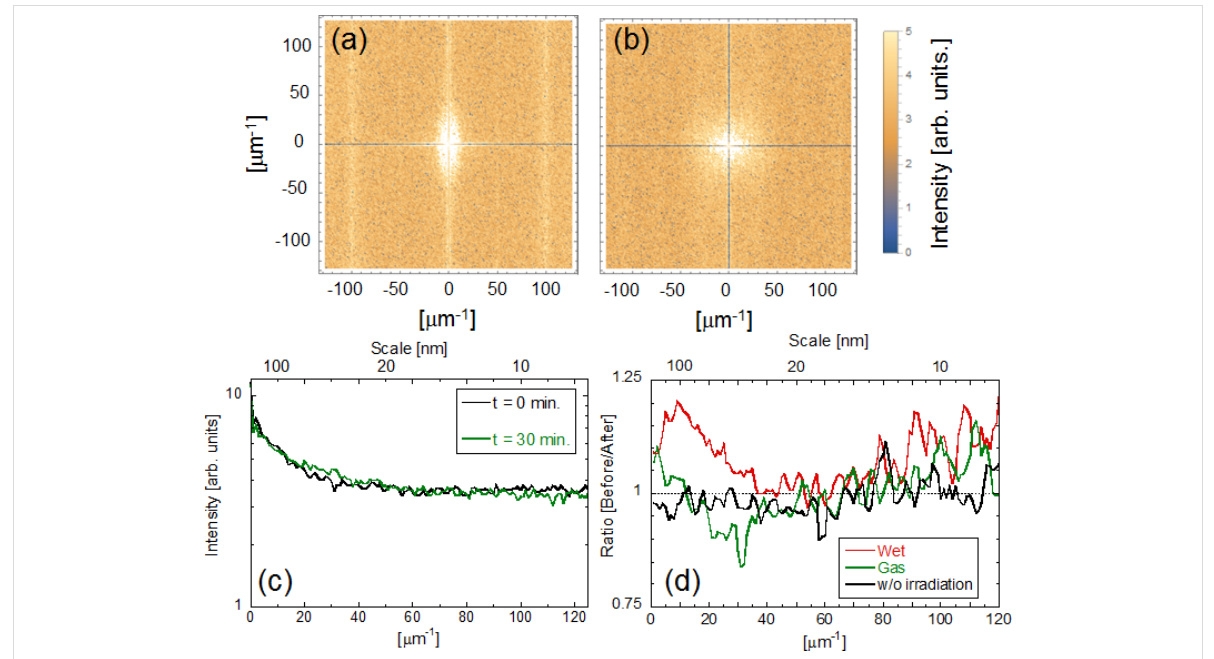
Figure 6: Time dependence of Fourier power spectra using a gas. Fourier power spectra taken (a) before etching and (b) after 30 min. (c) Averaged cross-sectional profiles. (d) Ratio of the power spectra before to the power spectra after etching. Red solid line: before ( t = 0 min)/after ( t = 35 min) etching using a solution, black solid line: before ( t = 0 min)/after ( t = 10 min) etching using a solution without irradiation, green solid line: before ( t = 0 min)/after ( t = 30 min) etching using a gas.